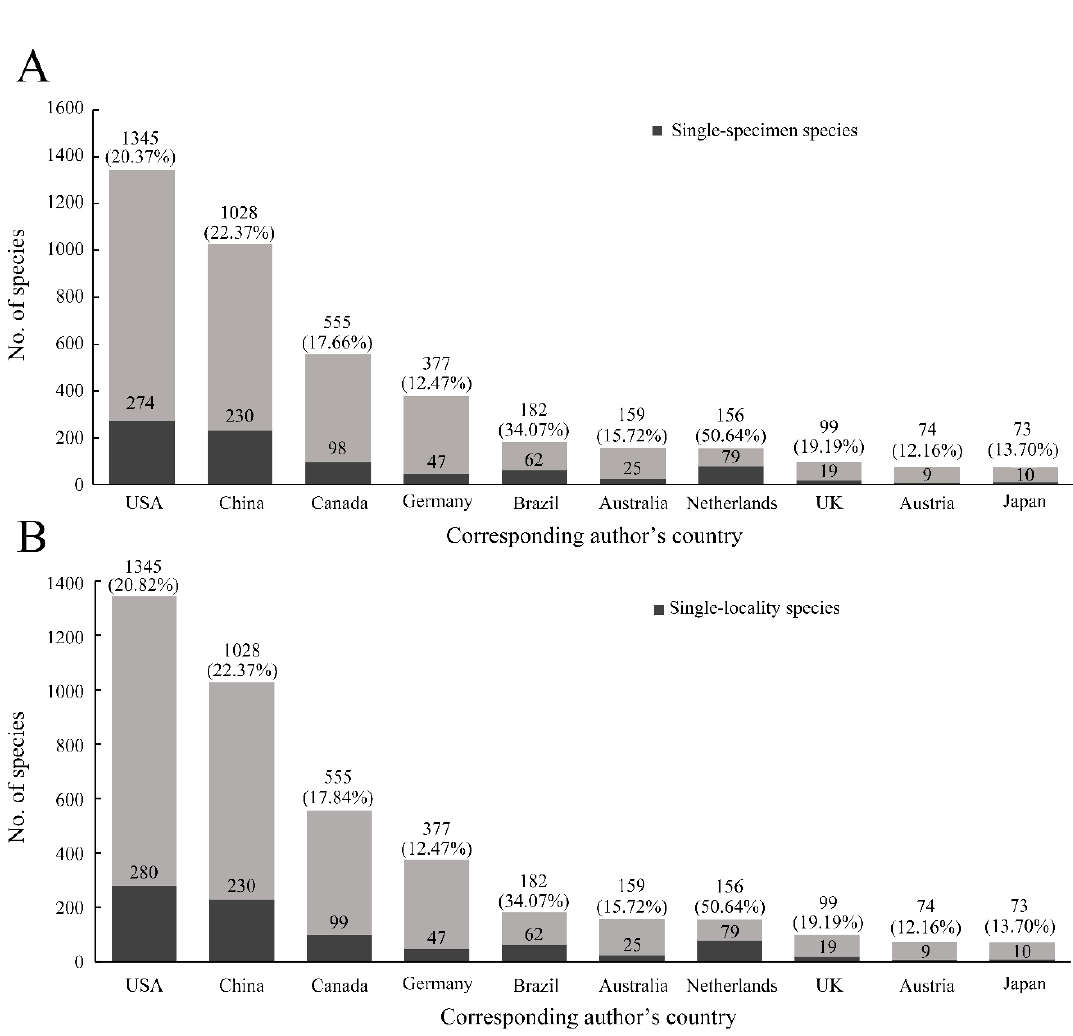
Figure 2. Numbers (dark gray) and relative proportions (percentages in parentheses) of ( A ) single-specimen species and ( B ) single-locality species described by authors from the top 10 countries that published the most new species. Values before parentheses indicate the total numbers of species described.